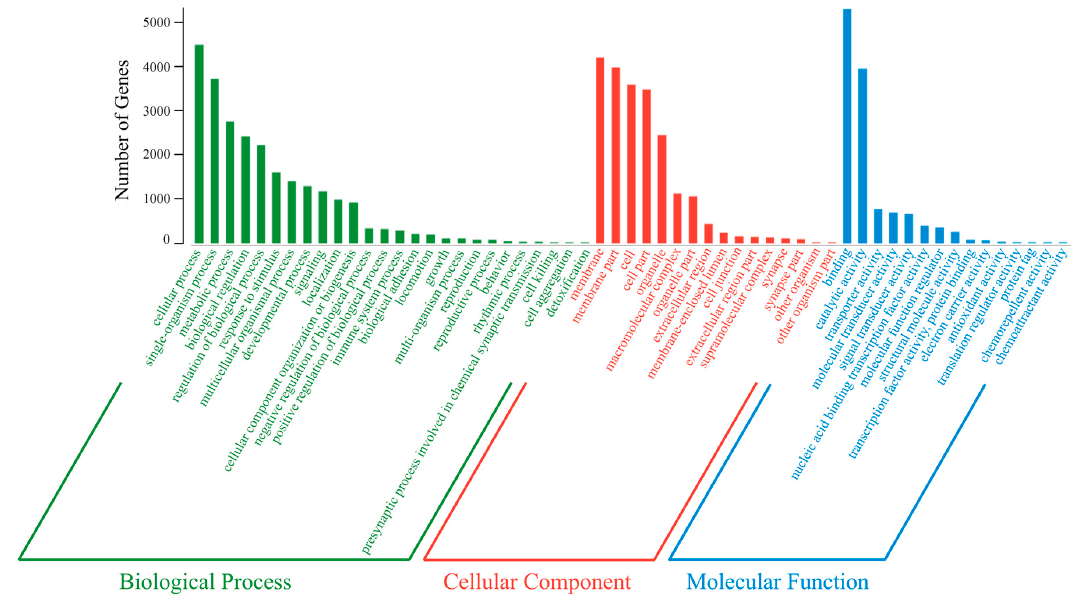
Figure 6 . The Gene Ontology annotations of the predicted target genes of the DE miRNAs. The 57 subcategories are plotted on the x-axis, while the number of genes in a specific functional cluster are shown on the y-axis.